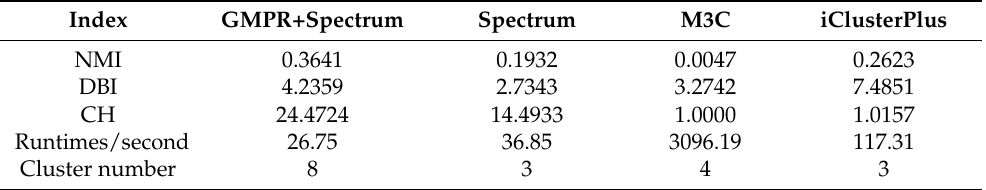
Table 1. Clustering evaluation indicators of four different algorithms in all samples.